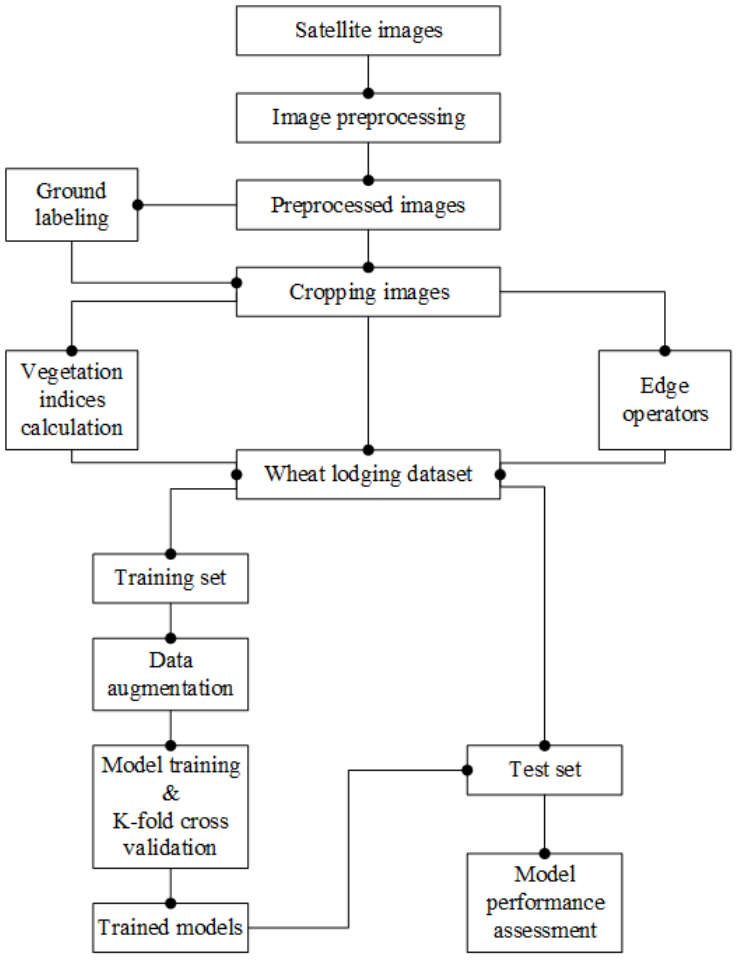
Figure 5. Flowchart of wheat lodging extraction.